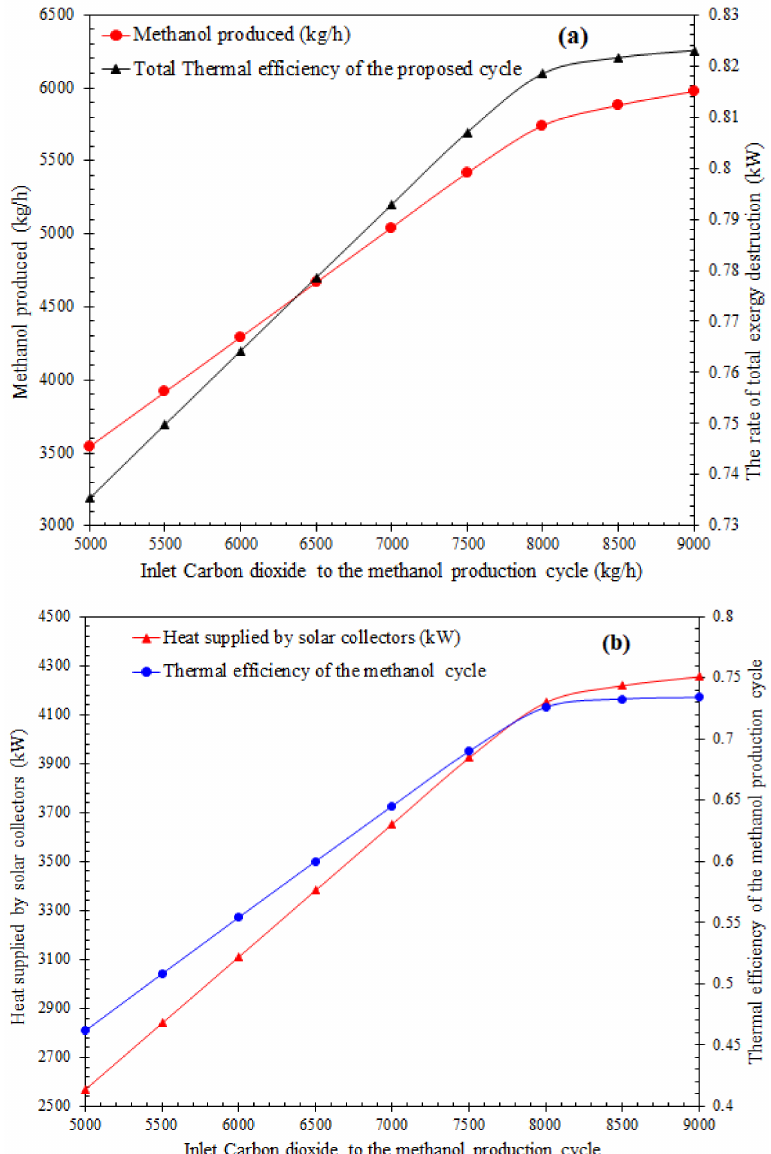
Figure 12. The effect of the changes of the CO 2 flow rate on main output parameters: ( a ) The influence of the changes of the CO 2 flow rate on the methanol production rate and total exergy destruction; ( b ) The influence of the changes of the CO 2 flow rate on heat supplied by solar collectors and the thermal efficiency of the methanol production